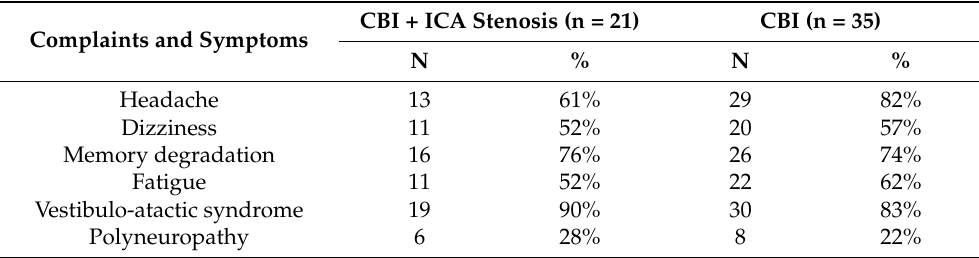
Table 3. Complaints and symptoms of patients with chronic brain ischemia (CBI) and CBI + internal carotid artery (ICA)